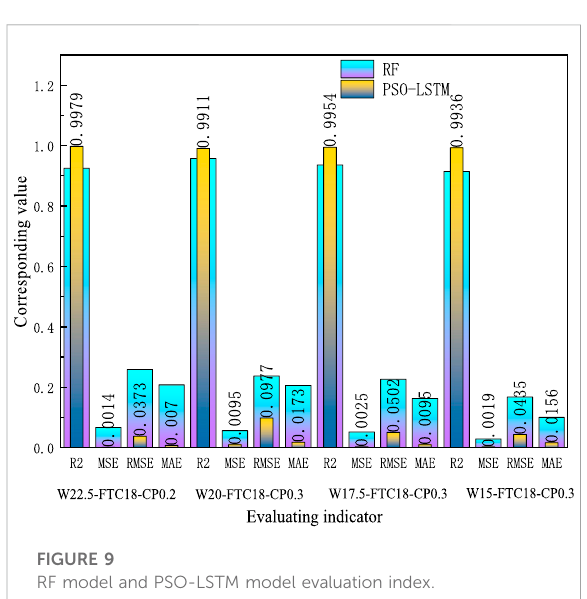
FIGURE 9 RF model and PSO-LSTM model evaluation index.